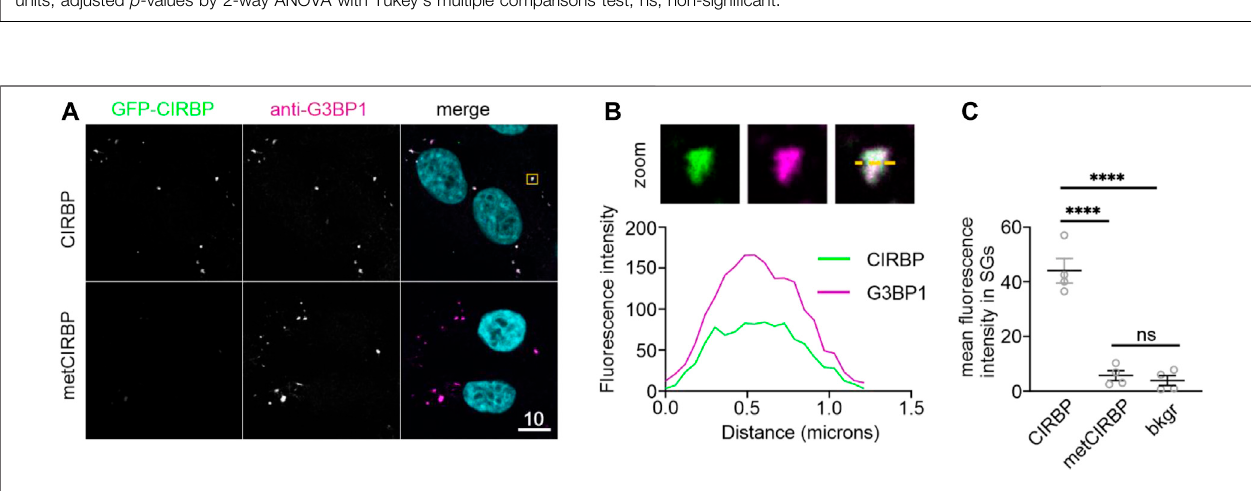
FIGURE 3 | Recruitment of CIRBP into G3BP1-positive condensates in intact cells depends on phosphorylation of the RG/RGG region. (A) Association of GCR 2 - GFP 2 -CIRBP (upper panel), GCR 2 -GFP 2 -CIRBP 3D mutant (middle panel), and GCR 2 -GFP 2 -CIRBP 3A mutant (bottom panel) with cytoplasmic condensates positiveforG3BP1inHeLacells.Scalebar:20 μ m. (B) Quanti fi cationofenrichmentofGCR 2 -GFP 2 -CIRBPwt,3Dor3AmutantinG3BP1-positivecondensatesoverthe cytoplasm (foci/cyt ratio) as a mean of 4 independent replicates ± SEM depending on the cellular expression levels represented in bins of fl uorescence intensity units, adjusted p -values by 2-way ANOVA with Tukey ’ s multiple comparisons test; ns, non-signi fi cant.